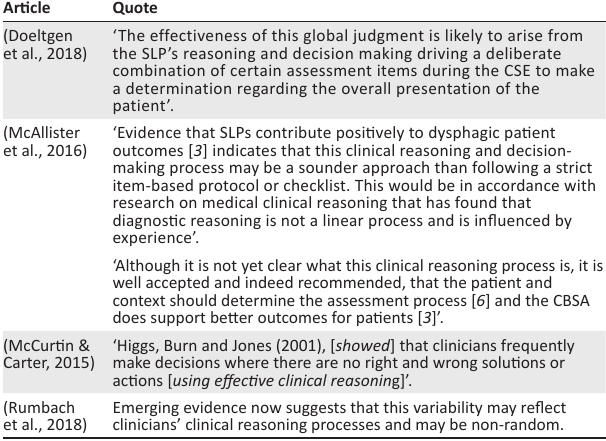
TABLE 2: Data extracts on the impact of clinical